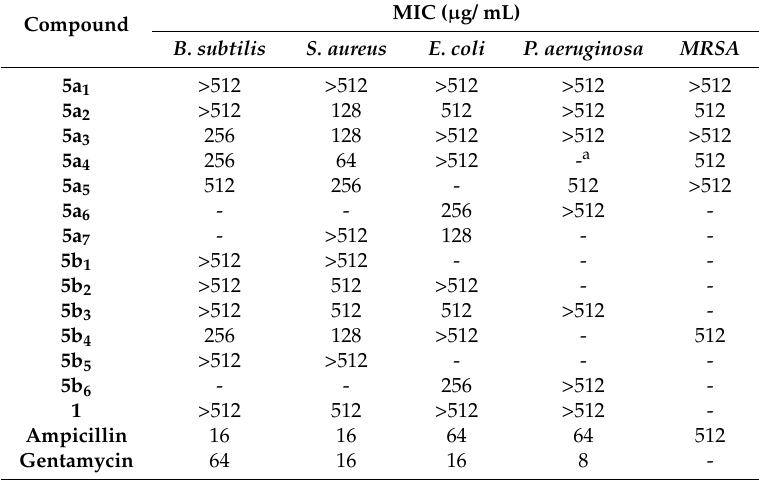
Table 2. The minimum inhibitory concentration (MIC) values of the synthesized compounds against